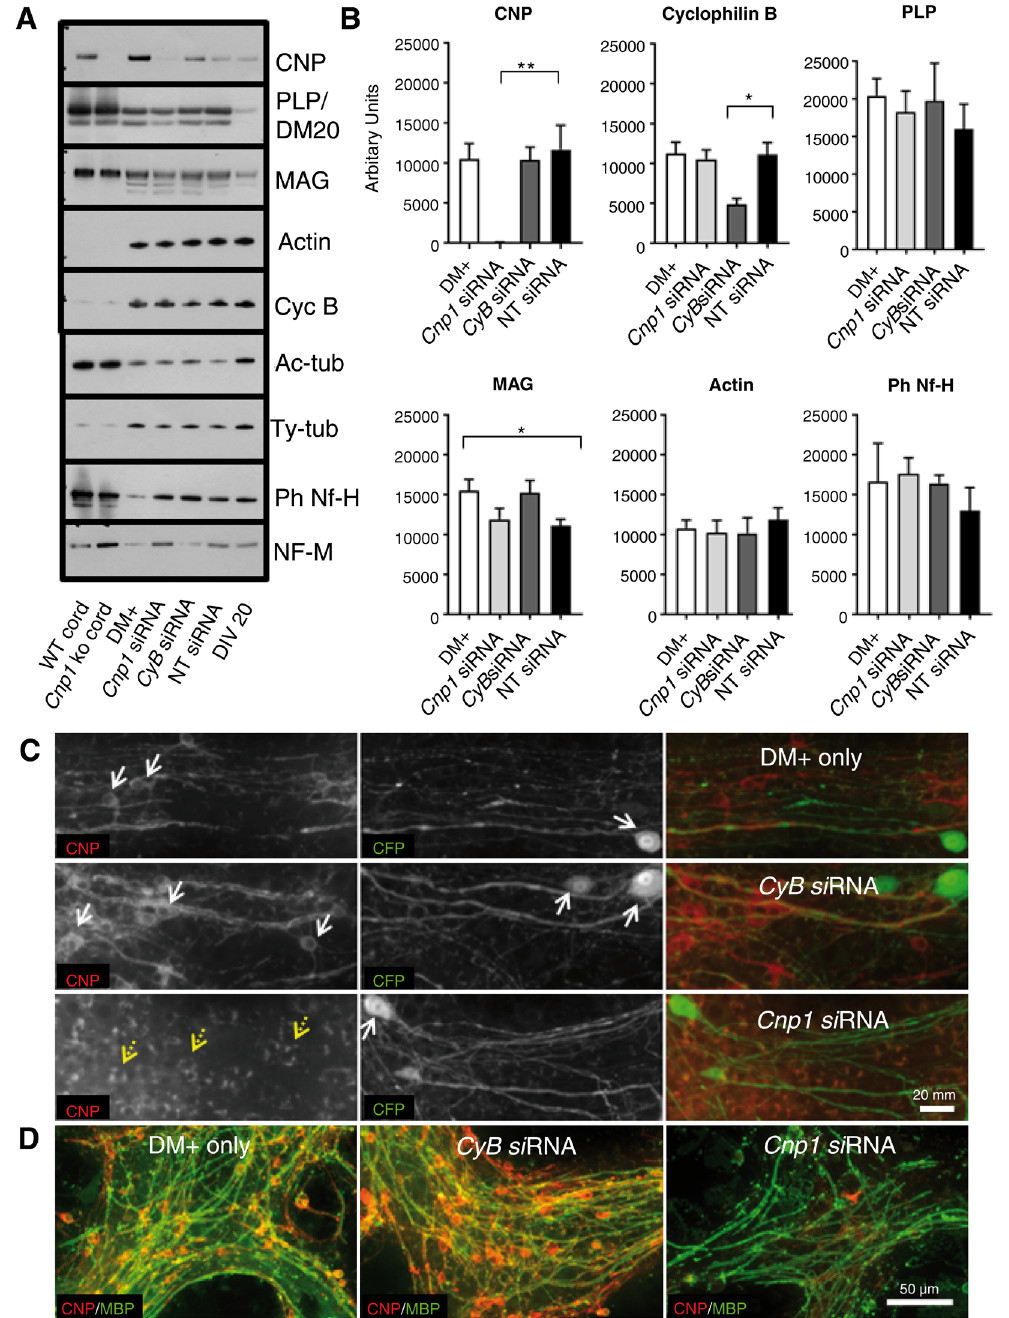
Figure 5. Spinal cord cultures are amenable to gene knockdown using siRNA. A . Western blots of (from L to R) spinal cord lysates from wild type and Cnp1 knockout (ko) mice and cell lysates from DIV 30 spinal cord cultures following treatment with supplemented incubation medium only (DM+), Cnp1 siRNA, CyB siRNA or non-targeting (NT) siRNA. Lysates from time 0 (DIV 20) cultures, were run alongside. B . Quantification myelin proteins, housekeeping proteins and axonal proteins in siRNA treated cultures. Bars represent mean +/- s.e.m. Values were obtained from n = 4–7 independent cultures. Seven independent experiments were undertaken but some proteins were only examined in 4, 5 or 6 of these as shown in the attached raw data files. All 7 experiments were probed for CNP and 6 of 7 were probed for cyclophilin B, against which the siRNA was designed. * p < 0.05, ** p < 0.01. C . Micrographs of cultures prepared from Thy1-CFP mouse embryos, treated with DM+, CyB siRNA or Cnp1 siRNA, and stained with anti-GFP (binds CFP which is expressed in a subset of neurons) and anti CNP. White arrows point to CNP +ve oligodendrocyte cell bodies or CFP +ve neuronal cell bodies. The punctate ‘staining’ indicated with broken yellow arrows represents autofluorescent lipofuscin granules, which are prevalent in these cultures. CNP is markedly reduced in Cnp1 siRNA-treated cultures. D . Micrographs of cultures treated with DM+, CyB siRNA or Cnp1 siRNA, and stained with anti-MBP (MBP is located in compact myelin) and anti-CNP (CNP is located in non-compact myelin). CNP is markedly reduced in Cnp1 siRNA-treated cultures, but MBP appears